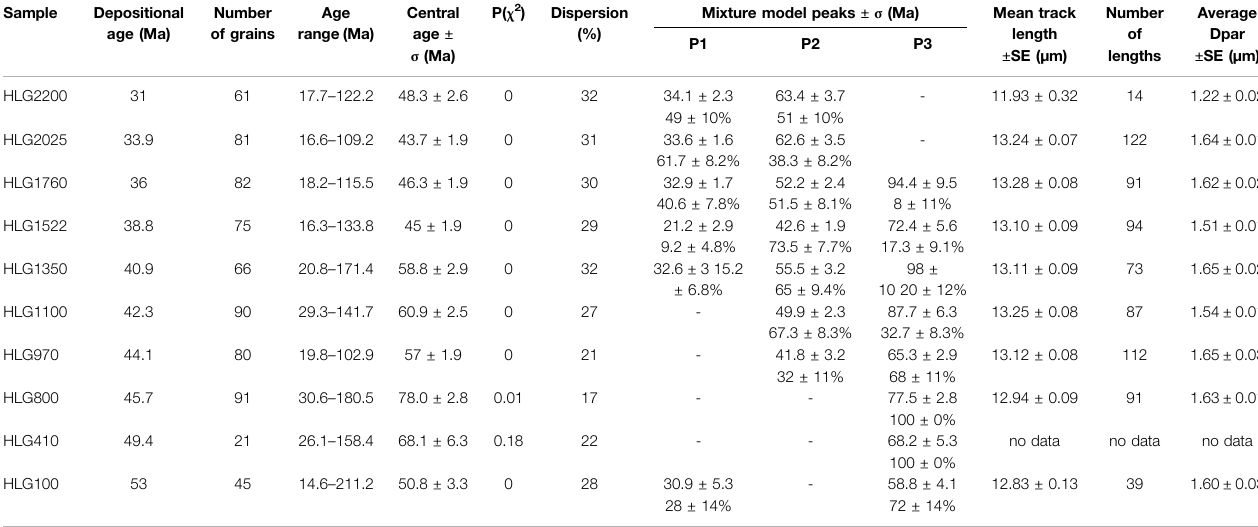
TABLE 1 | AFT dating